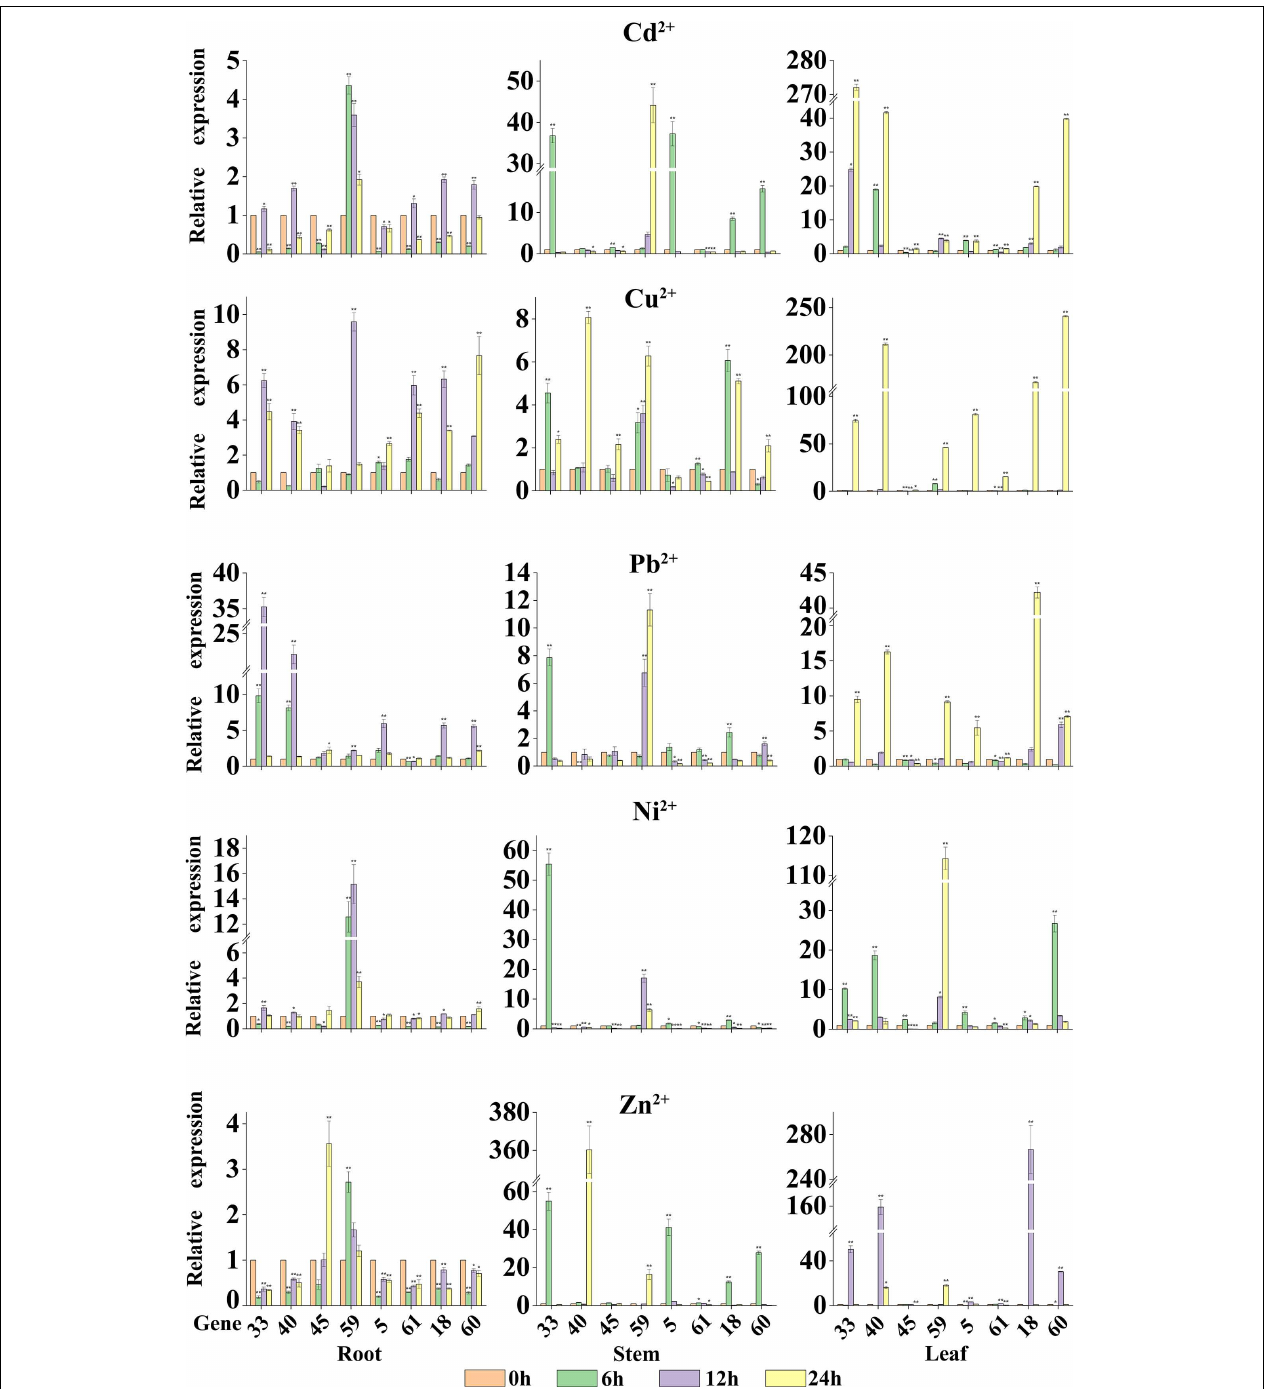
FIGURE 7 | The relative expression levels of eight StMATE genes in response to the five heavy metals. The ordinate is the gene expression level; abscissa is the gene number. The height of the bar graphs represents the relative expression levels of the genes where the value of the expression is equal to the means ( ± SD) of three biological replicates. The gene names are shown on the x axis (* P < 0.05; ** P <